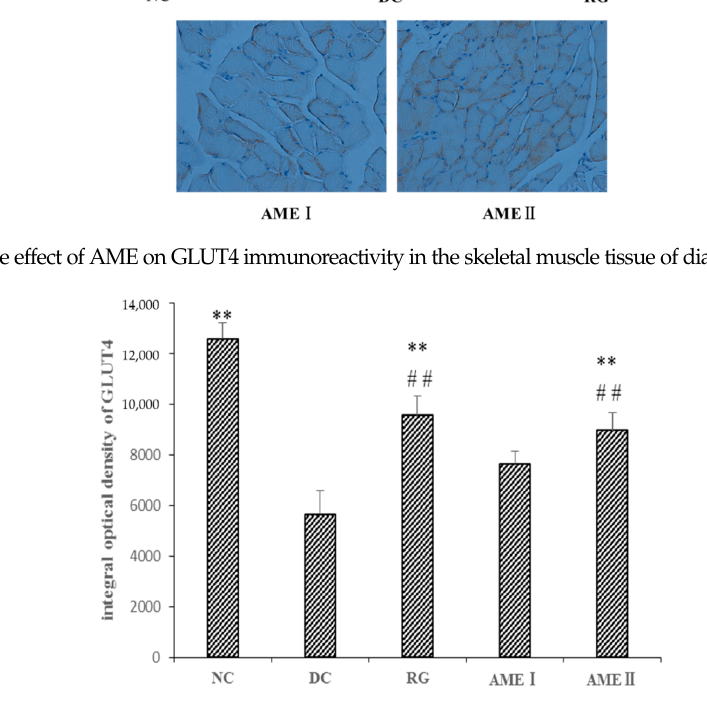
Figure 6. The effect of AME on GLUT4 immunoreactivity in the skeletal muscle tissue of diabetic mice. ( n = 10), # p < 0.05, ## p < 0.01 compared with normal control group; * p < 0.05, ** p < 0.01, compared with the diabetic control group.